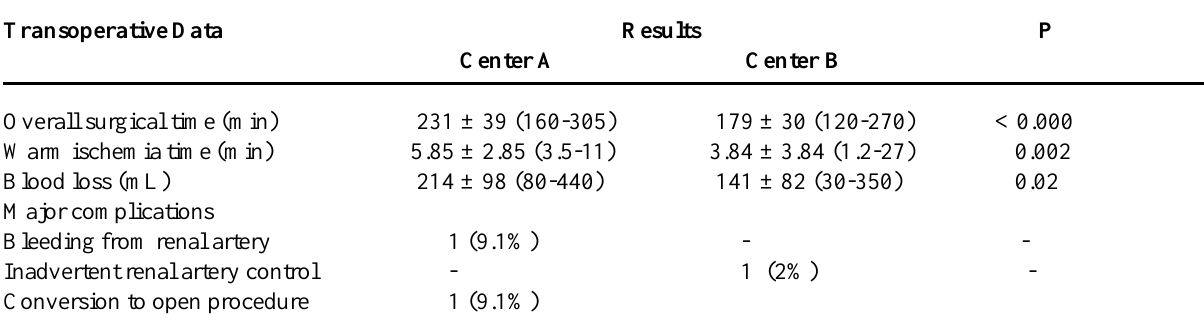
Table 1 – Transoperative data of donors.